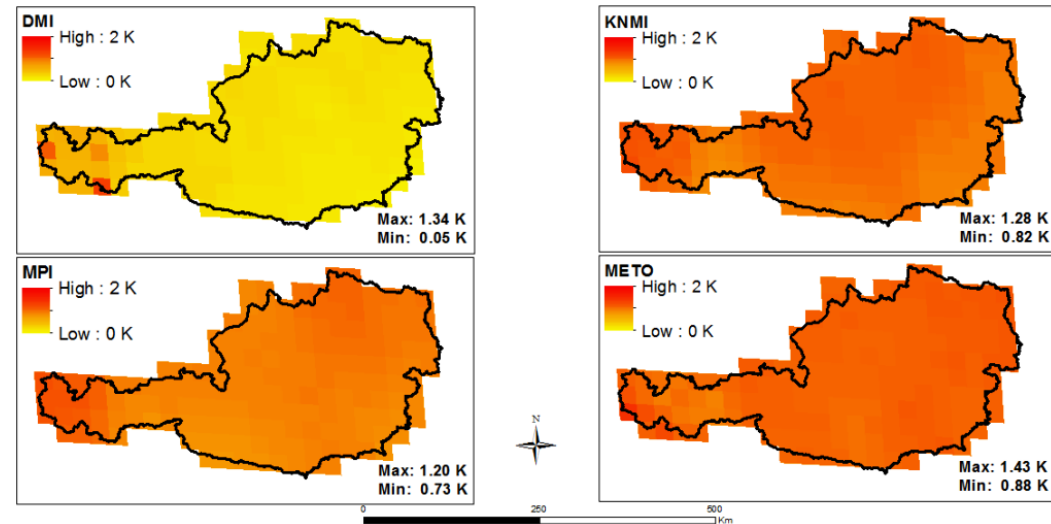
Figure 6. Absolute difference of mean air temperature in the summer season (JJA) between the periods 1961–1990 and 2011–2040.